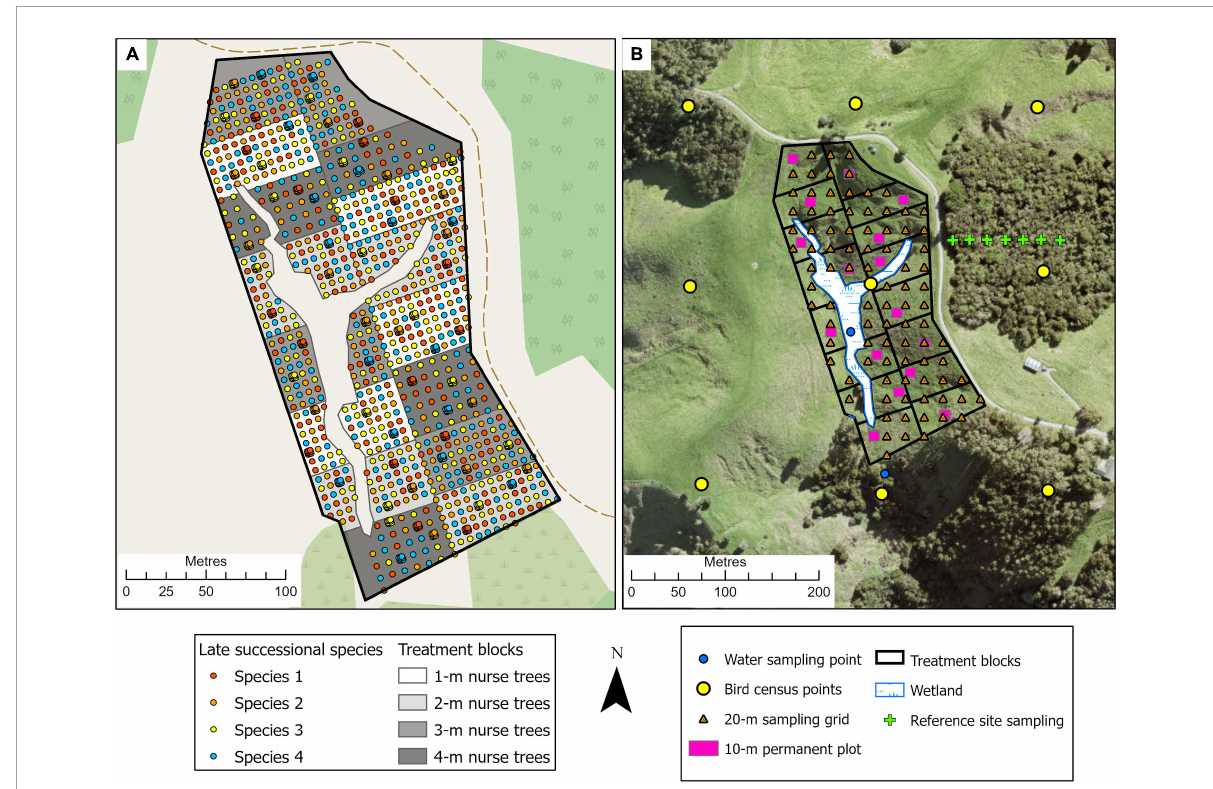
FIGURE2 Illustration of the tree planting, treatment block, and site monitoring design for the Te Muri experimental site. (A) The treatments involve mixed-species nurse trees planted at four densities; across the site, four late-successional canopy species are planted singly, and in clusters of nine seedlings 1-m apart, in a randomized design (see Tables 1 , 2 ). Survival and performance of both target and nurse tree species are monitored through time. (B) Monitoring design, at the landscape scale (e.g., bird observations, water quality), at the treatment block scale, within 10 × 10-m permanent plots (e.g., decomposition, natural seedling recruitment), and at the 20-m sampling grid scale (e.g., soil chemistry, soil